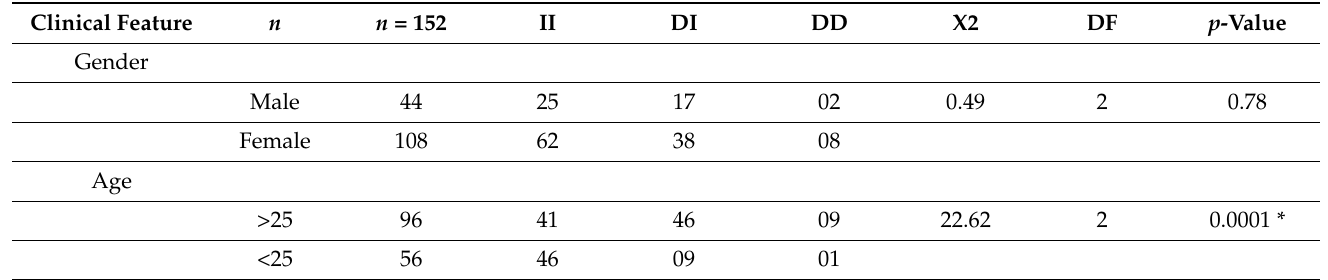
Table 11. Association of ACE I/D polymorphism genotype with patients’